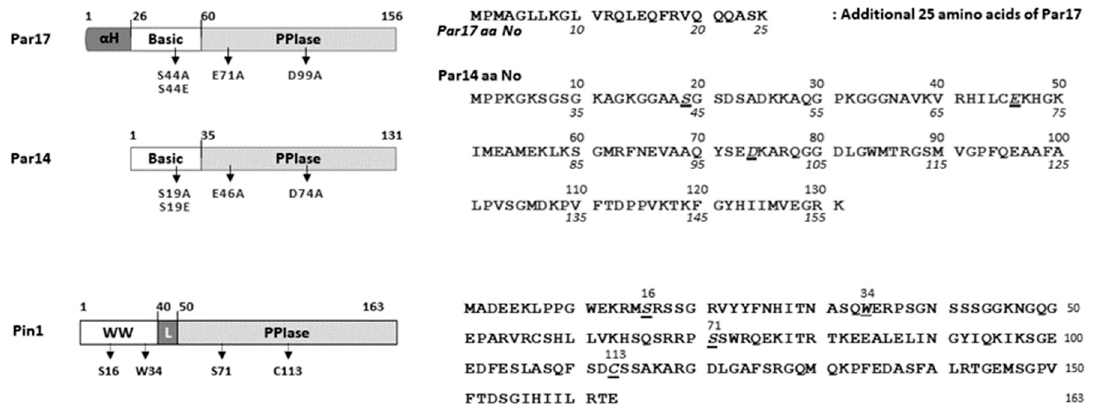
Figure 1. Schematic overview and amino acid sequences of the human PPIases Par17, Par14, and Pin1.